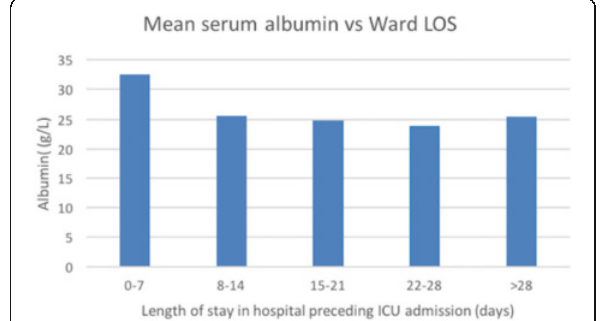
Fig. 139 (abstract A352). Albumin vs Ward